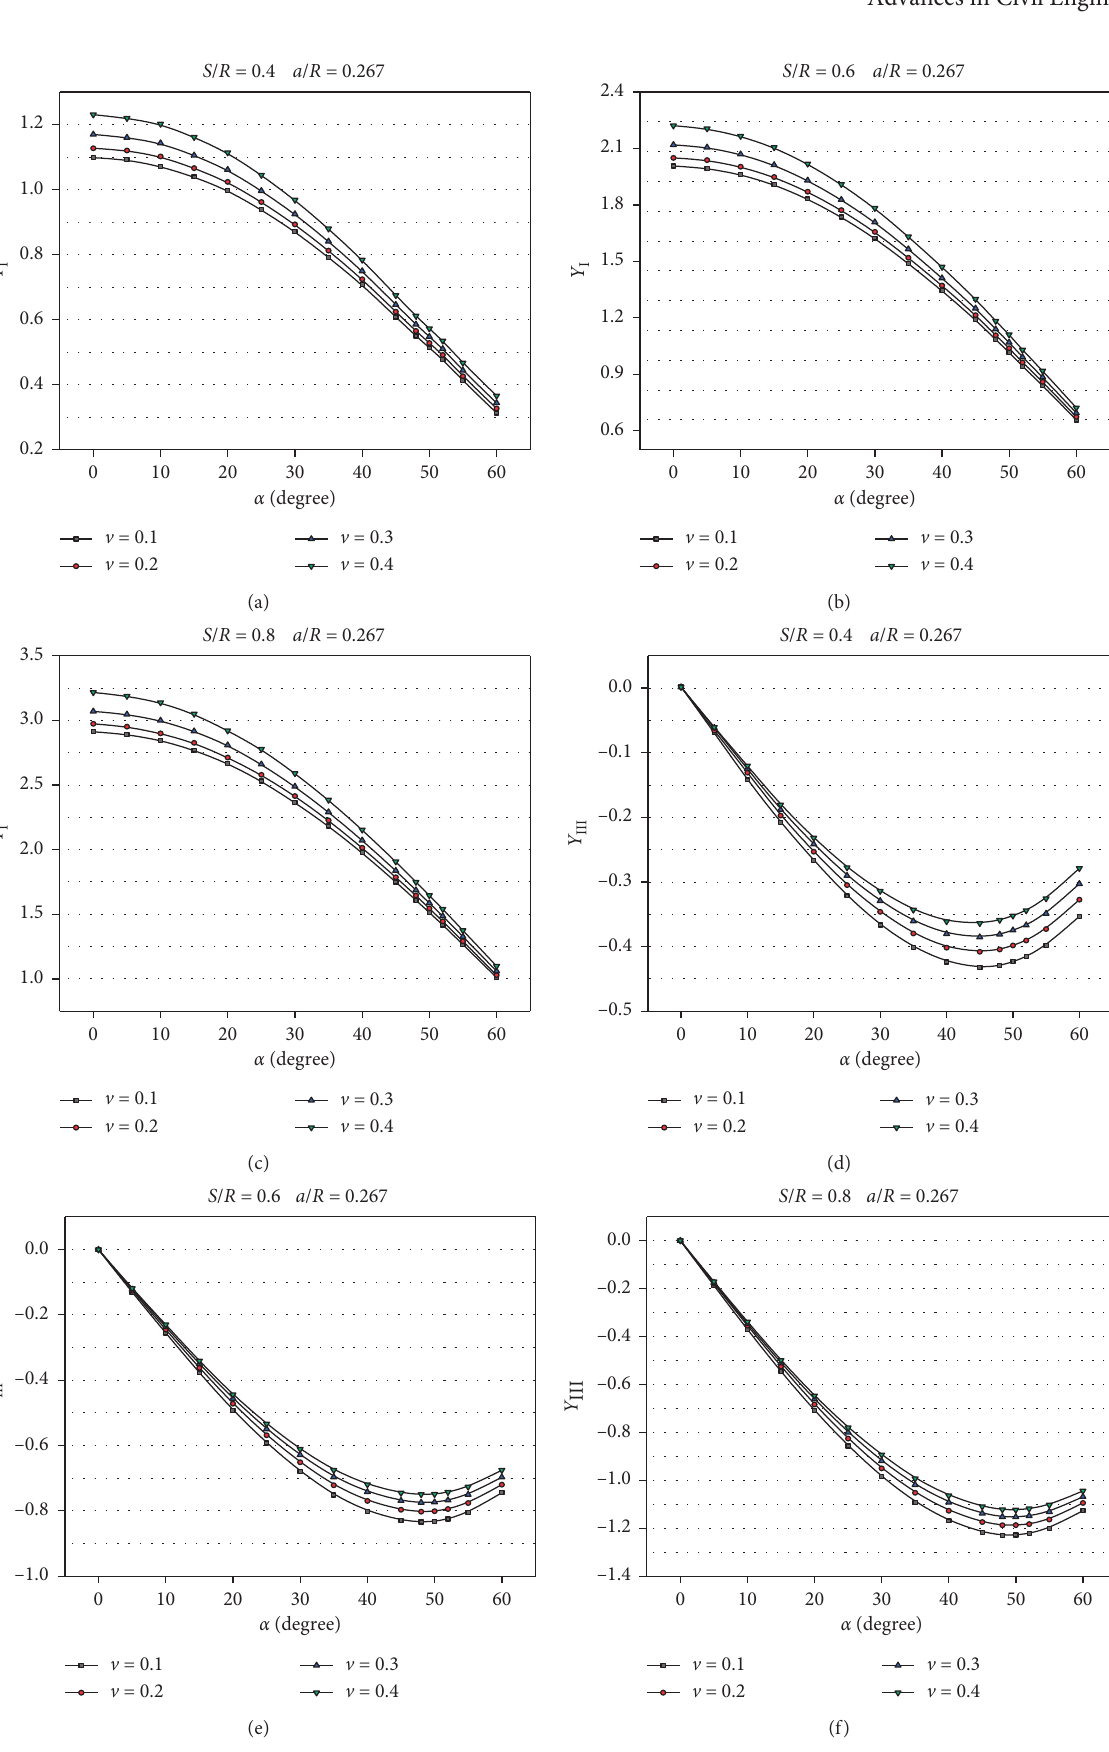
v values in the SCB